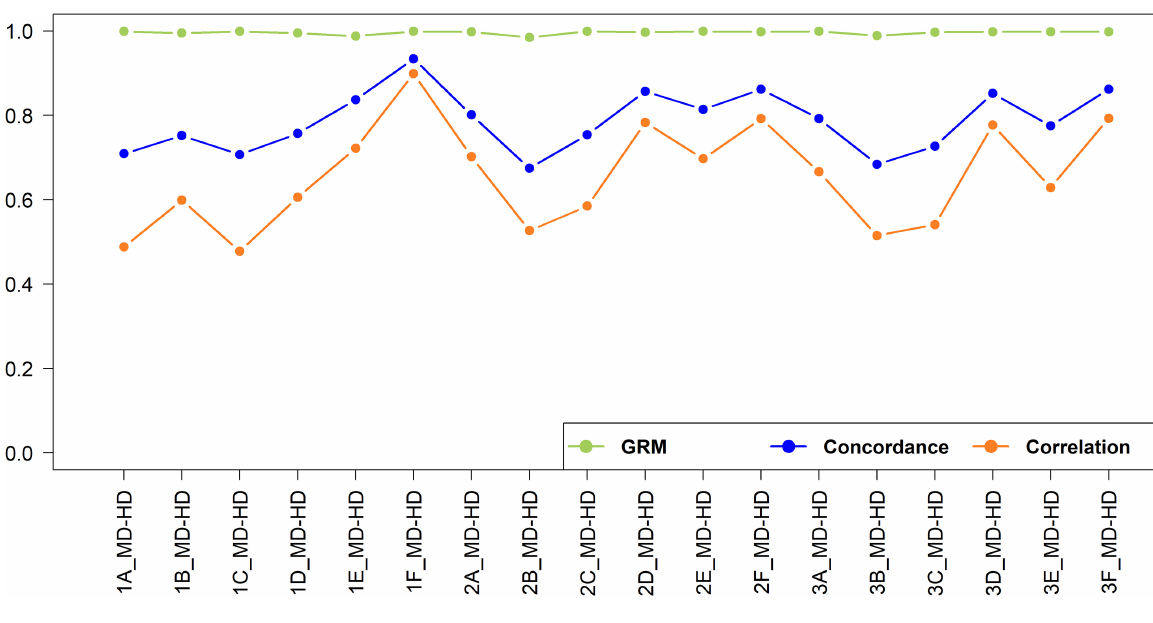
Frontiers in Genetics |